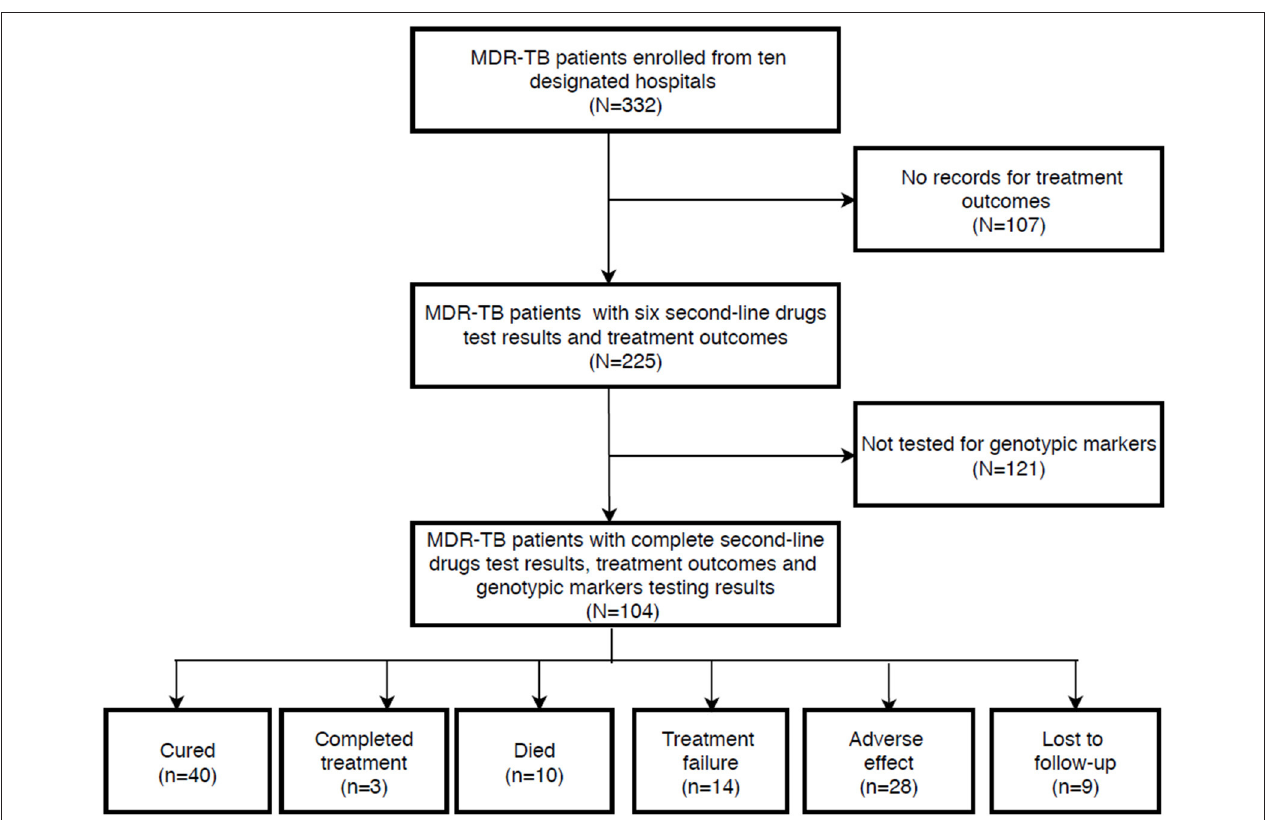
FIGURE 1 | Schematic presentation of patient flow